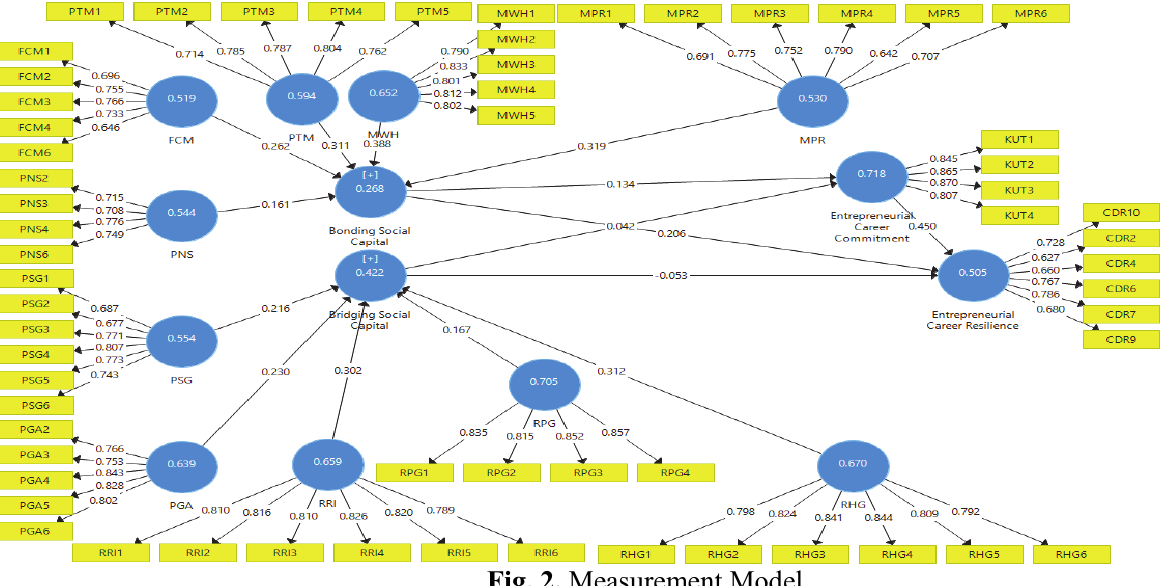
Fig. 2. Measurement